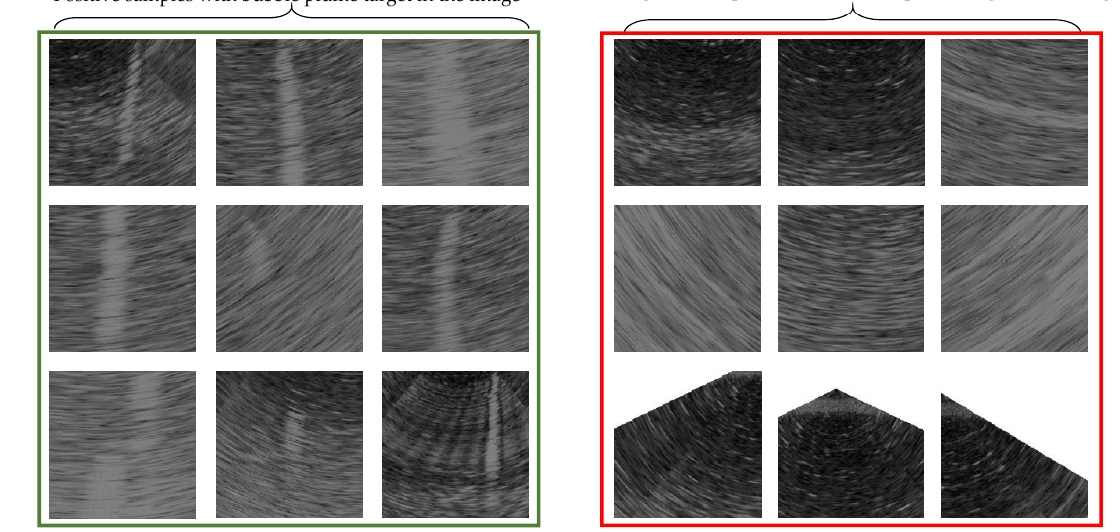
Figure 10. Positive and negative sampling from raw water column images.